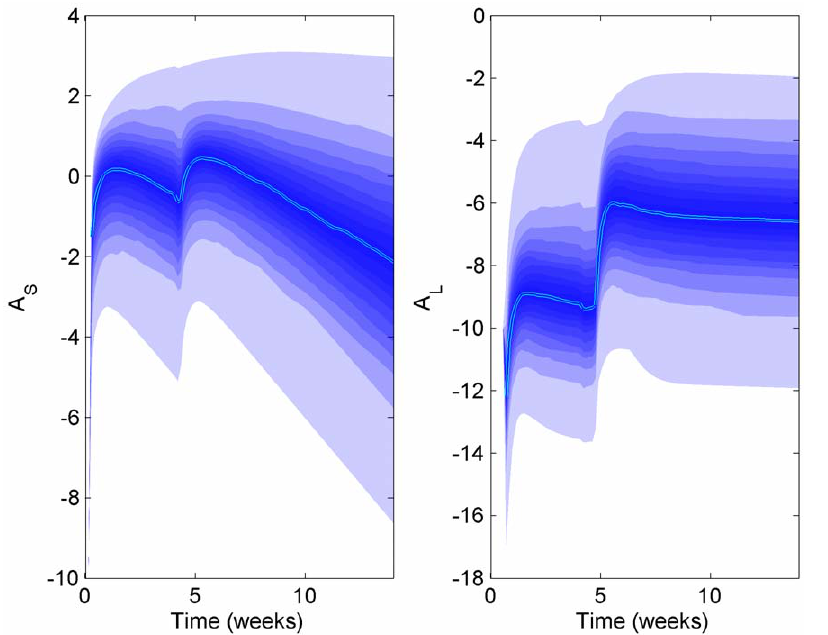
1 to 4 times the nominal values shows that 4